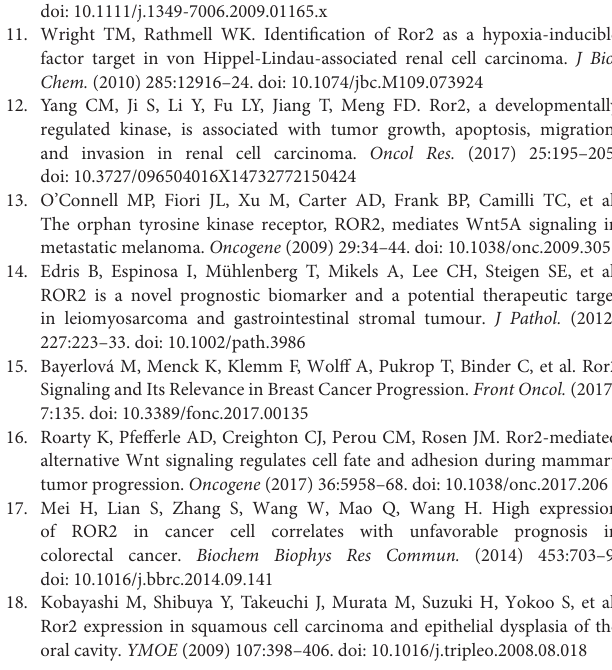
four-parameter curve fitting model in GraphPad